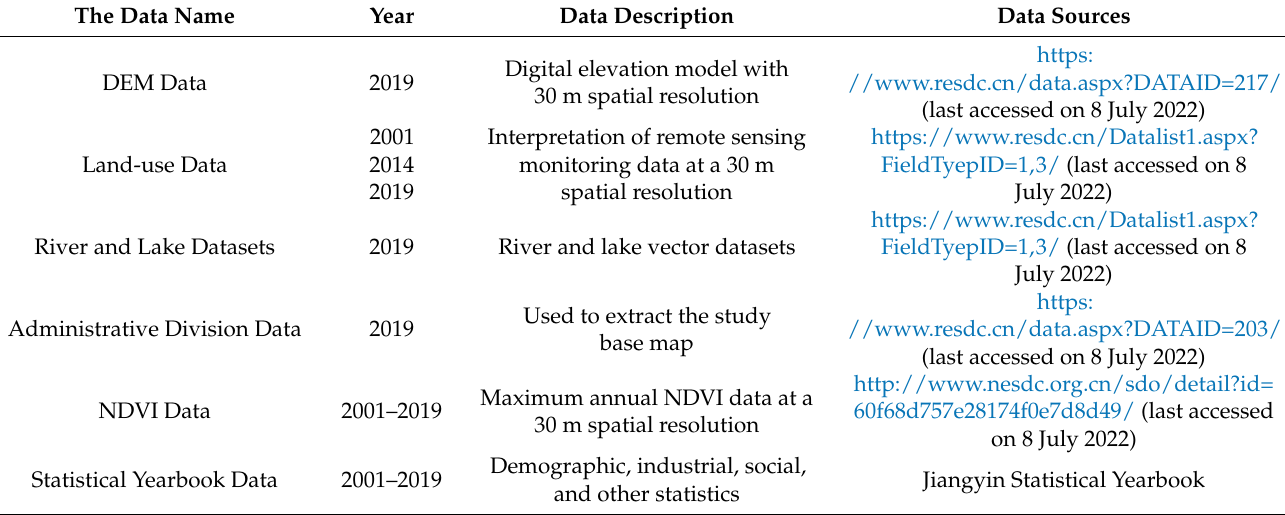
Table 1. Data sources for development performance evaluation indicators in Jiangyin